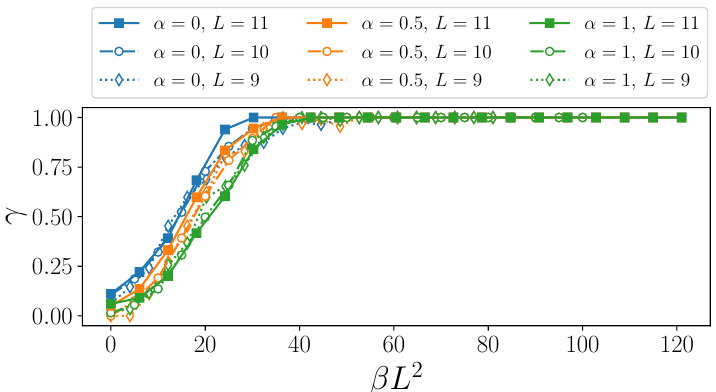
Figure 3: Dependence of the fitting parameter γ on the transition parameter β rescaled with L 2 for the three Liouvillian limits: rational constant α = 0, general hyperbolic α = 0.5 and separable α = 1, and for different system sizes L =